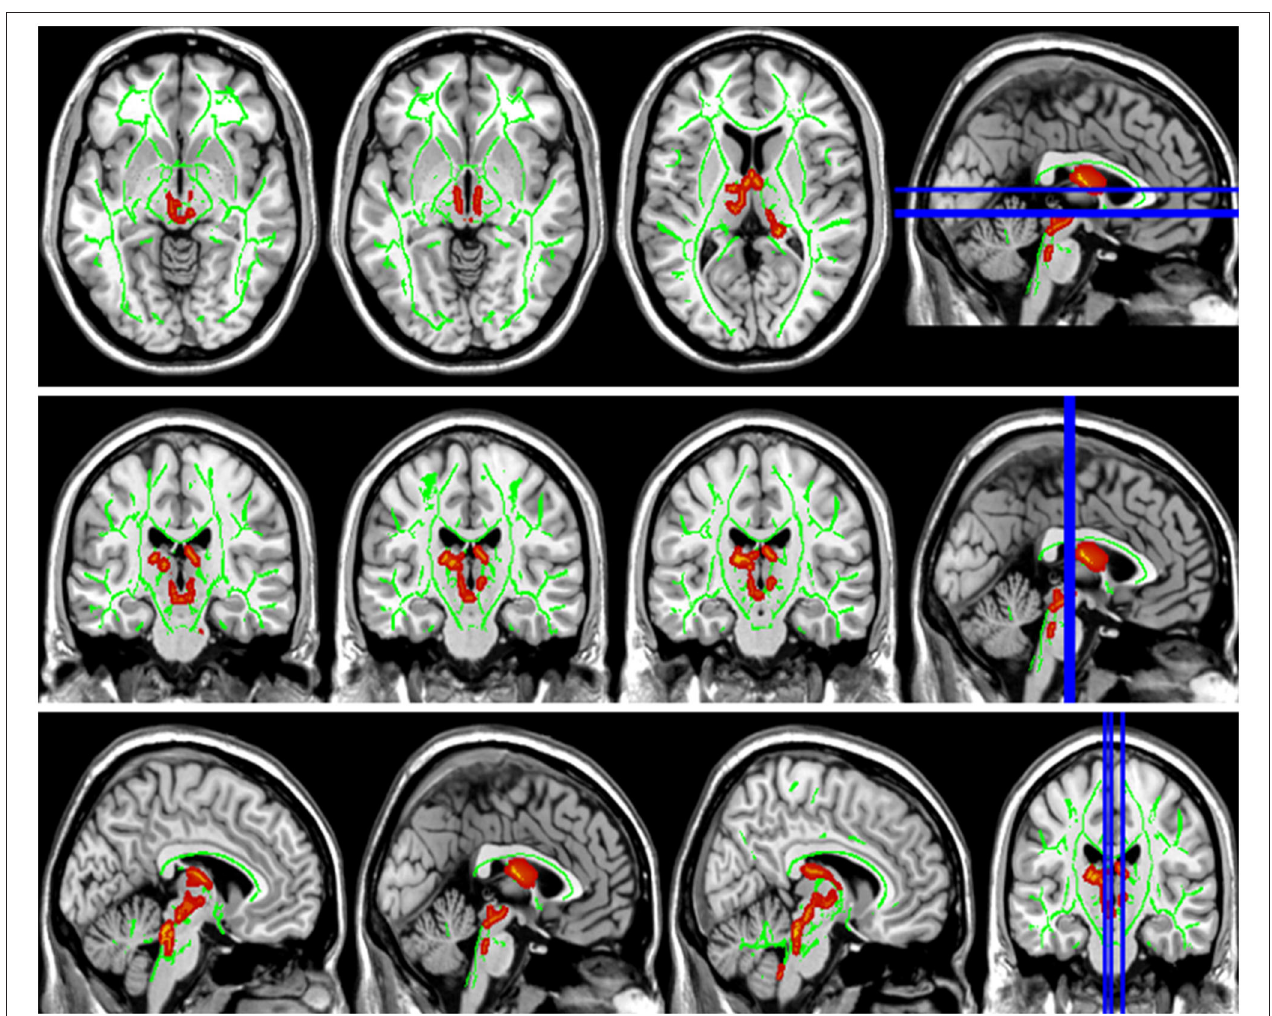
FIGURE 4 | Group differences in radial diffusivity (RD). The RD values in patients with LAN and RAN increased in bilateral anterior thalamic